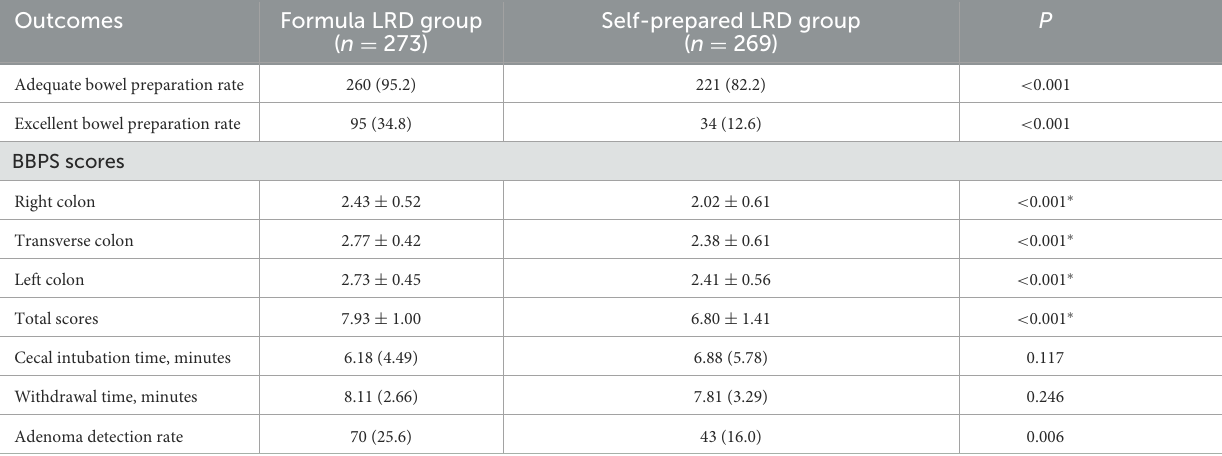
TABLE 4 Comparison of outcomes by PP